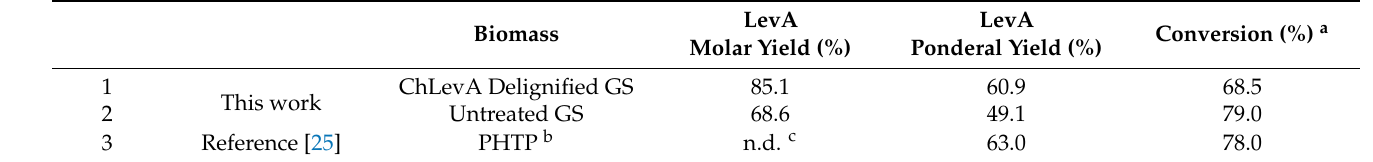
Table 3. Conversion of grape stalks (GS) to levulinic acid (LevA). Reaction conditions